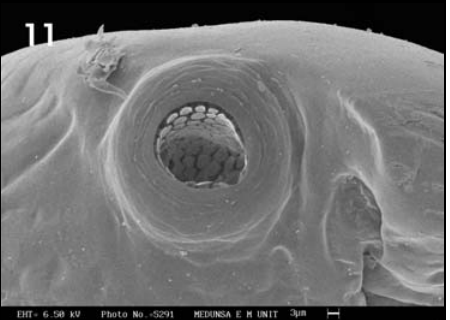
Fig. 11. A mesothoracic spiracle.